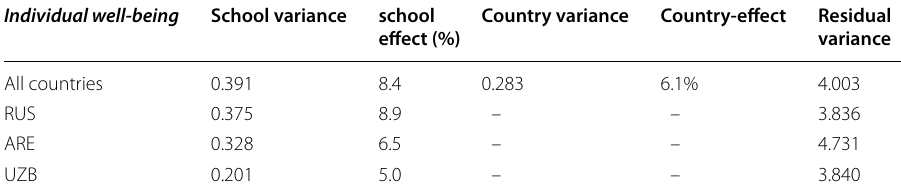
Table 4 PVRE by country and by school in teachers’ school-environment well-being School environment well-being All countries RUS